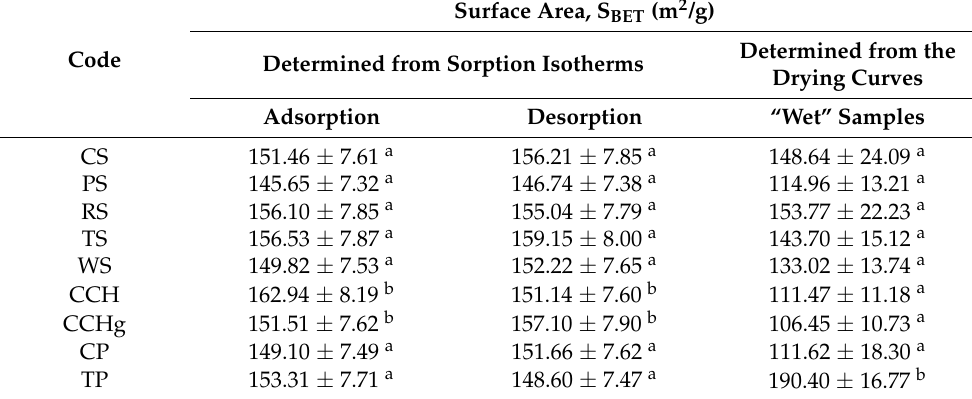
Table 2. Starch specific surface